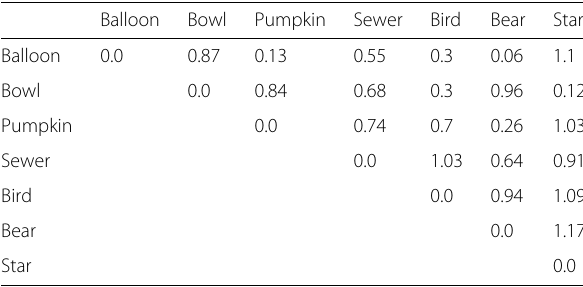
Table 3 Distance matrix of segmented images